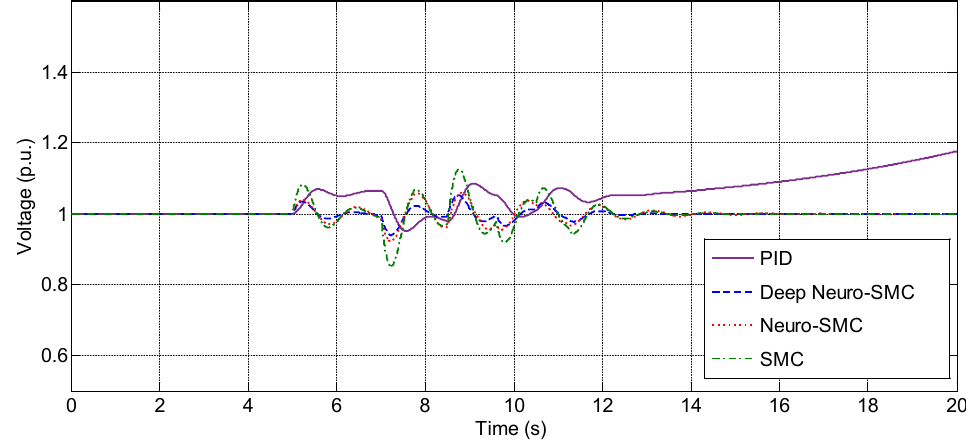
Figure 10. Bus number 5 voltage diagram (second case).